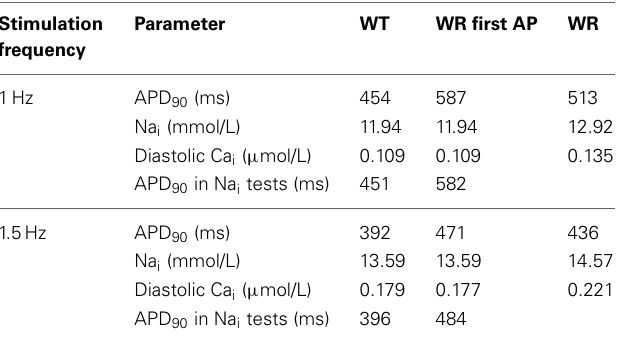
Table 2 | APD 90 , Na i , and diastolic Ca i at steady state recorded in the model during 1- and 1.5-Hz stimulation.